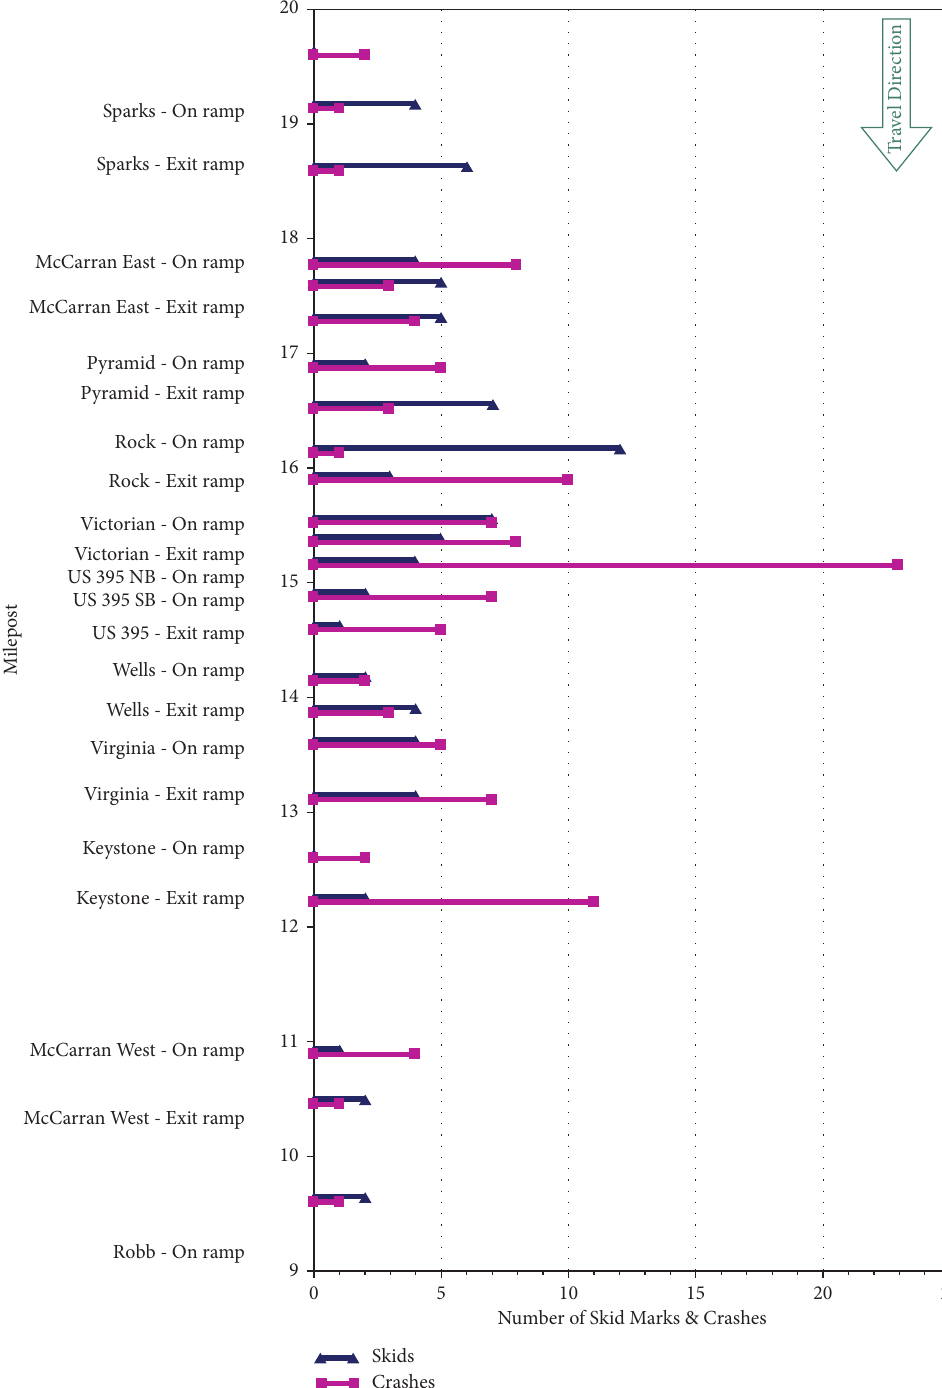
Figure 18: Crashes and skid marks at Interstate 80 westbound